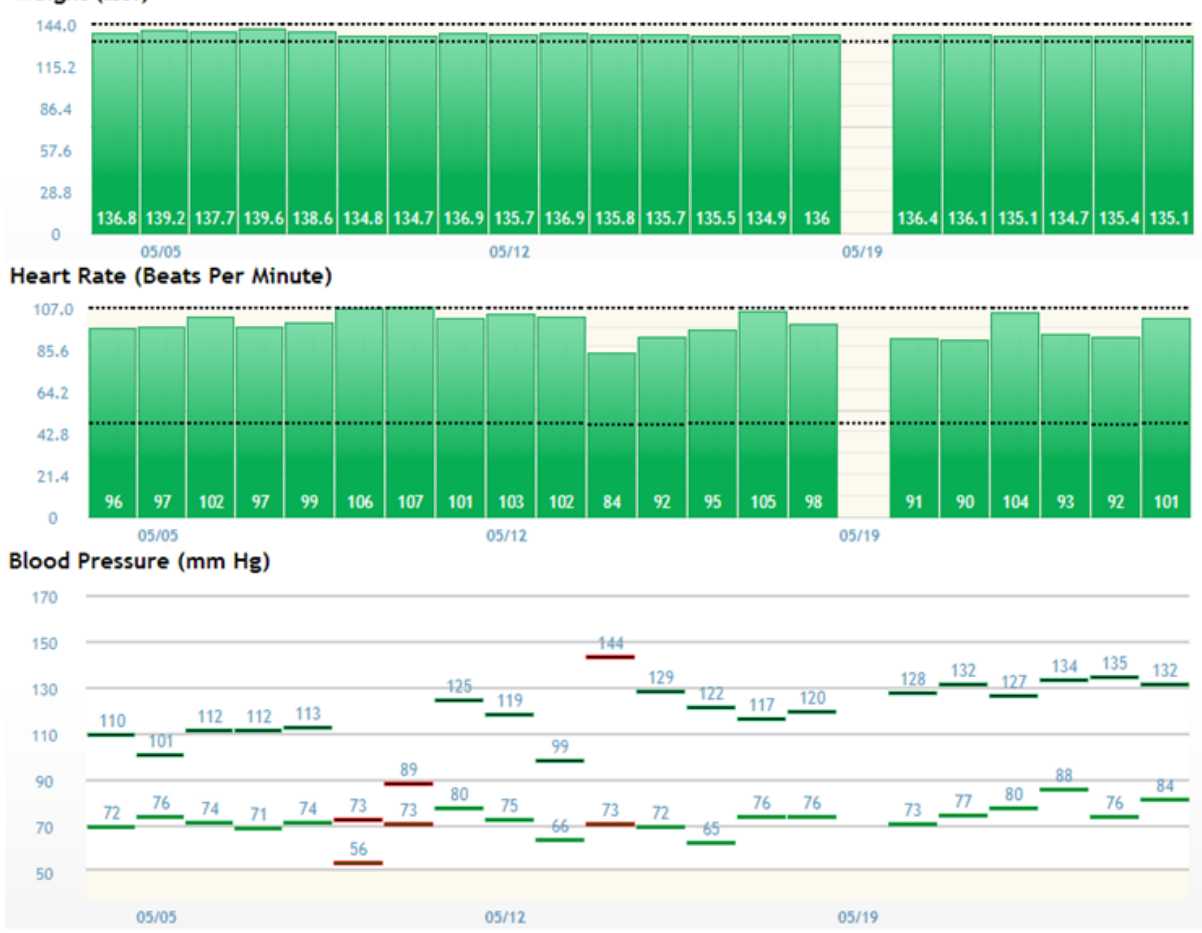
Figure 2. Screenshot of a sample progress report on the Web portal displaying a graphical representation of a patient’s vitals taken using study devices.